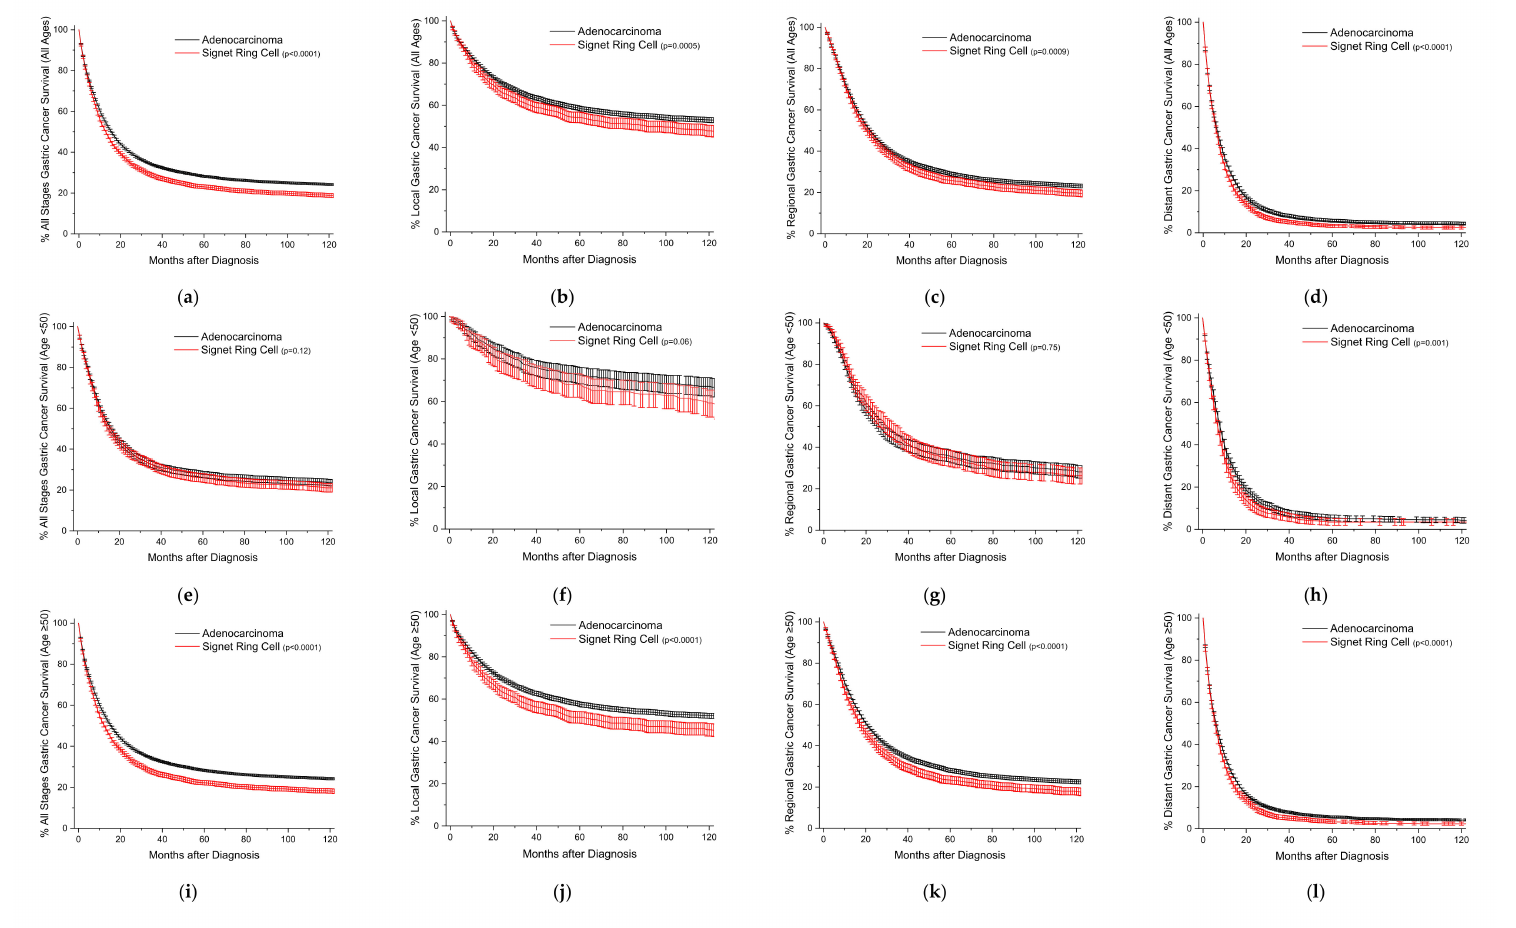
Figure 1. Kaplan-Meier survival curves for gastric cancer. All survivor functions are shown with 95% confidence intervals. ( a ) All ages, all stages. ( b ) All ages, local disease. ( c ) All ages, regional disease. ( d ) All ages, distant disease. ( e ) Age < 50, all stages. ( f ) Age < 50, local disease. ( g ) Age < 50, regional disease. ( h ) Age < 50, distant disease. ( i ) Age ≥ 50, all stages. ( j ) Age ≥ 50, local disease. ( k ) Age ≥ 50, regional disease. ( l ) Age ≥ 50, distant disease. p -values between curves by log-rank